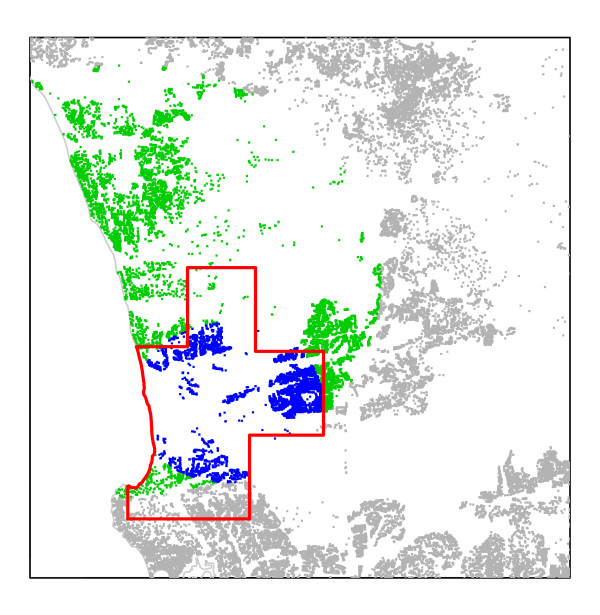
Consensus Cluster for RC A outlined in red. The qualifying SaTScan point clusters are green and blue; all other located births are gray.